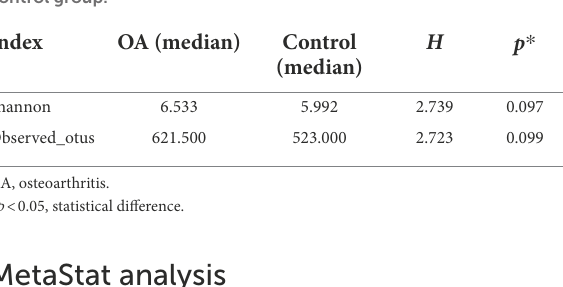
TABLE 3 Alpha diversity indices between the OA group and the control